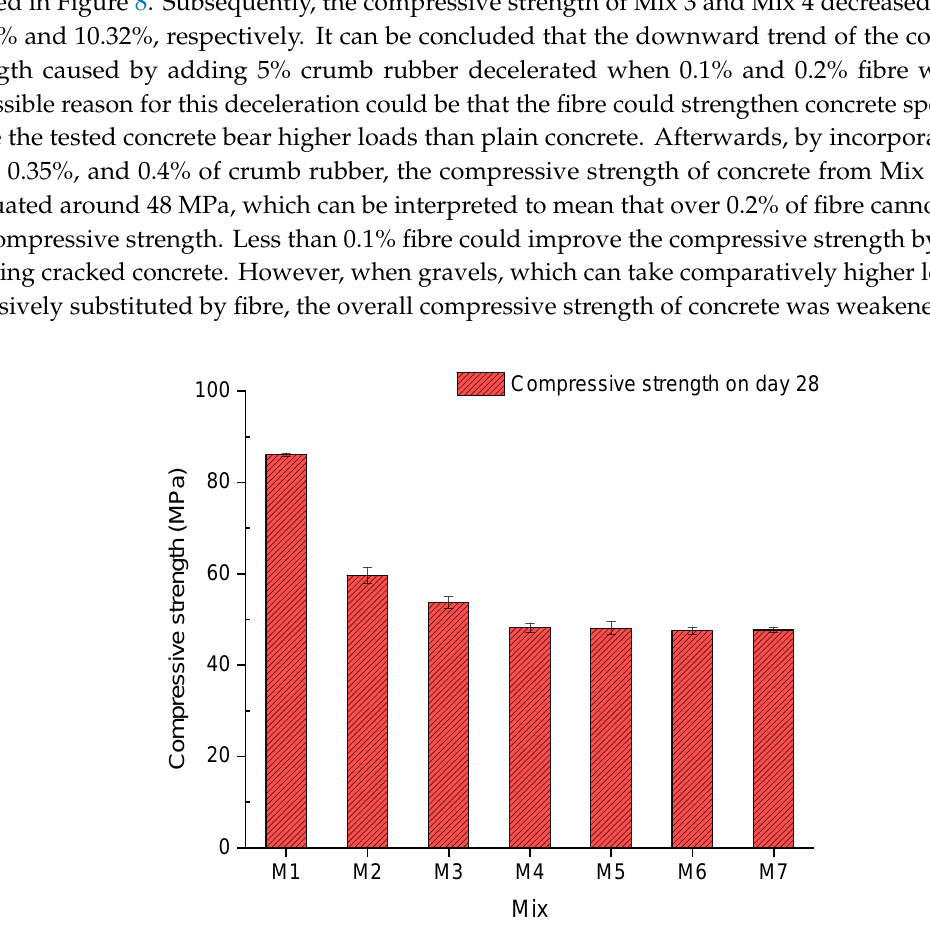
Figure 8. Compressive strength.